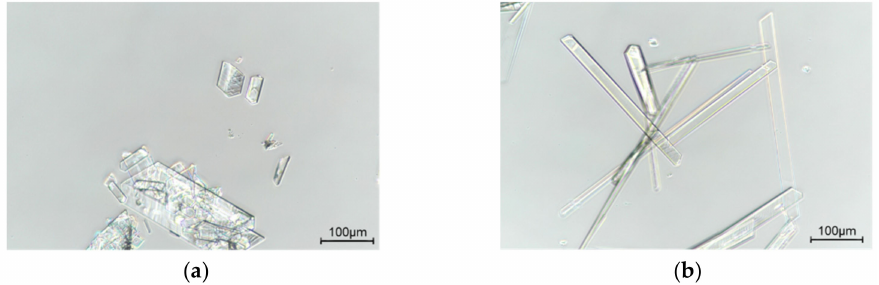
Figure 2. Compound micrographs of the crystal habit of Sor-Tos crystals grown from ( a ) acetone and ( b ) n-butanol.